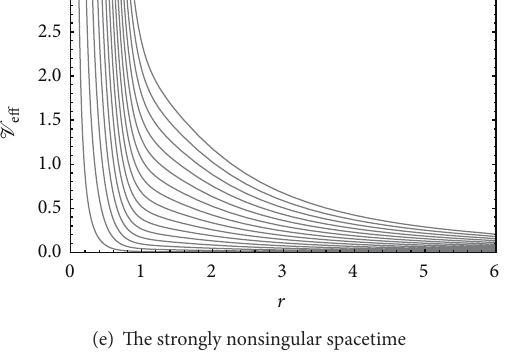
as a function of 𝑟 with different values of 𝐿 . eff